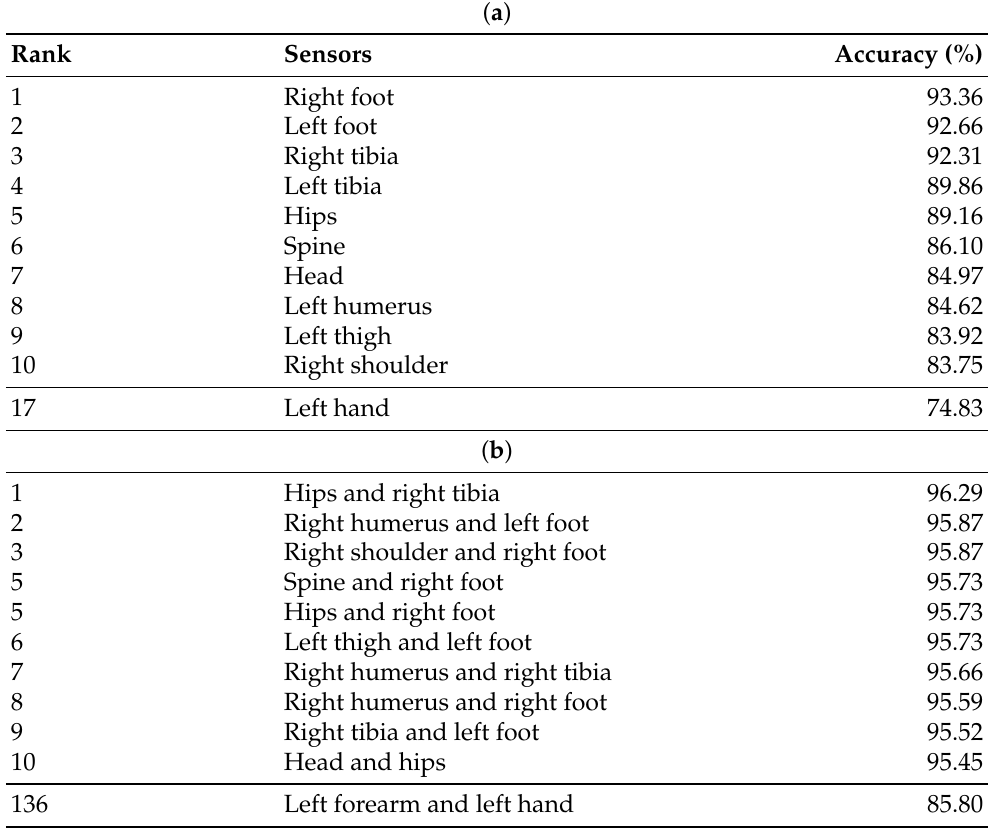
Table 10. One to ten (and worst) ranked sensors for SVM classifier (equipped state); ( a ) single sensor, ( b ) two-sensor